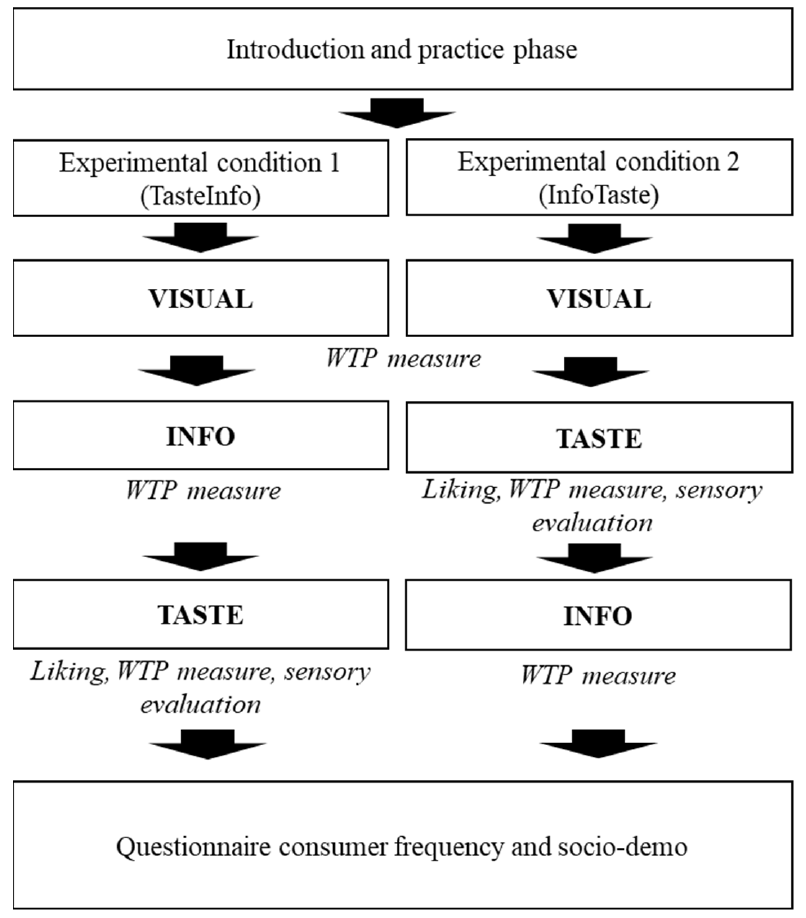
Figure 1. Flowchart of the experiment under two conditions (InfoTaste and TasteInfo). Each participant was randomly assigned to a condition.